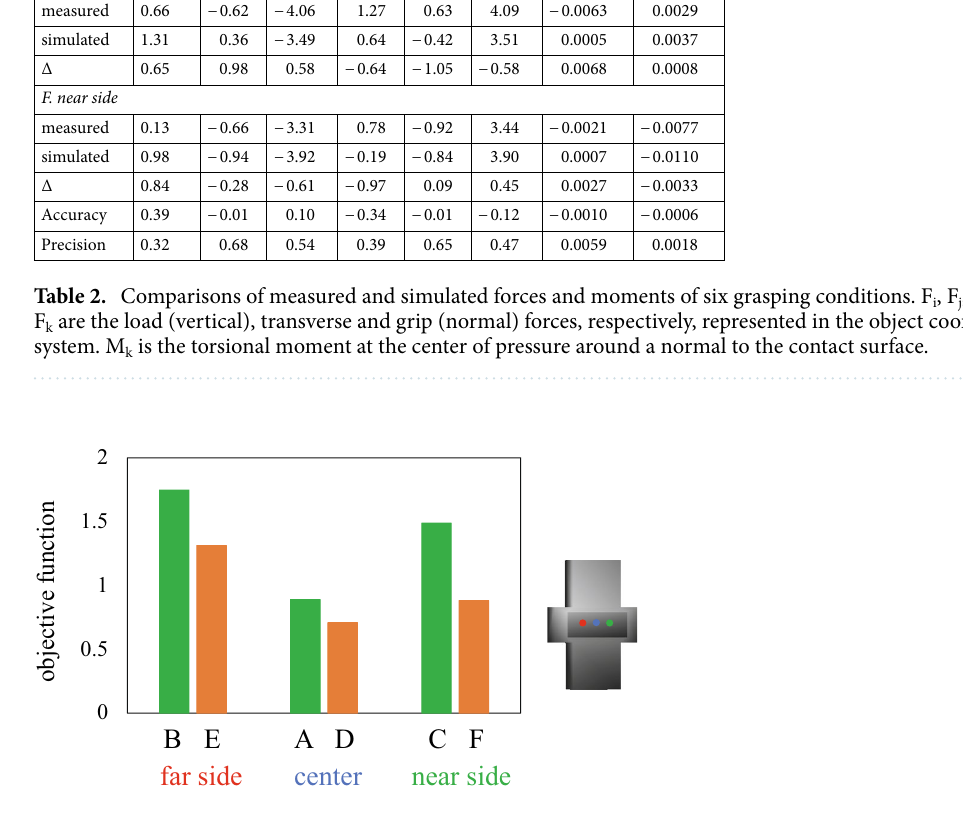
Figure 6. Comparison of the objective functions when the participant pinched the center, far side, and near side of the device with fingertips ( A , B , and C , respectively) and finger pulps ( D , E , and F , respectively). The value was smaller if the object was held with the finger pulps (orange) rather than the fingertips